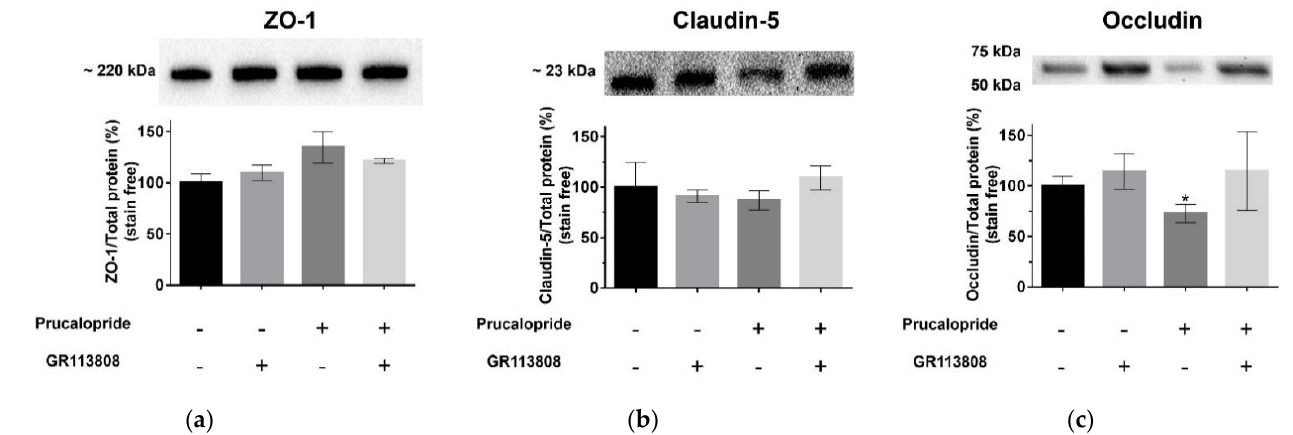
Figure 6. Western blot analysis showing the involvement of the 5-HT 4 receptor in the regulation of the expression of tight junction proteins in hCMEC/D3 cells. Cells were treated with GR113808 (1 µM), prucalopride (10 µM) or GR113808 (1 µM) + prucalopride (10 µM) for 96 h. Relative integrated density values of ( a ) ZO-1, ( b ) claudin-5 and ( c ) occludin are shown. No correlation is found between the treatment and the expression of ZO-1 and claudin-5. A significant negative correlation between treatment with prucalopride and the expression of occludin is apparent, compared to control. Histograms represent mean ± SEM from three independent experiments. * p < 0.05.